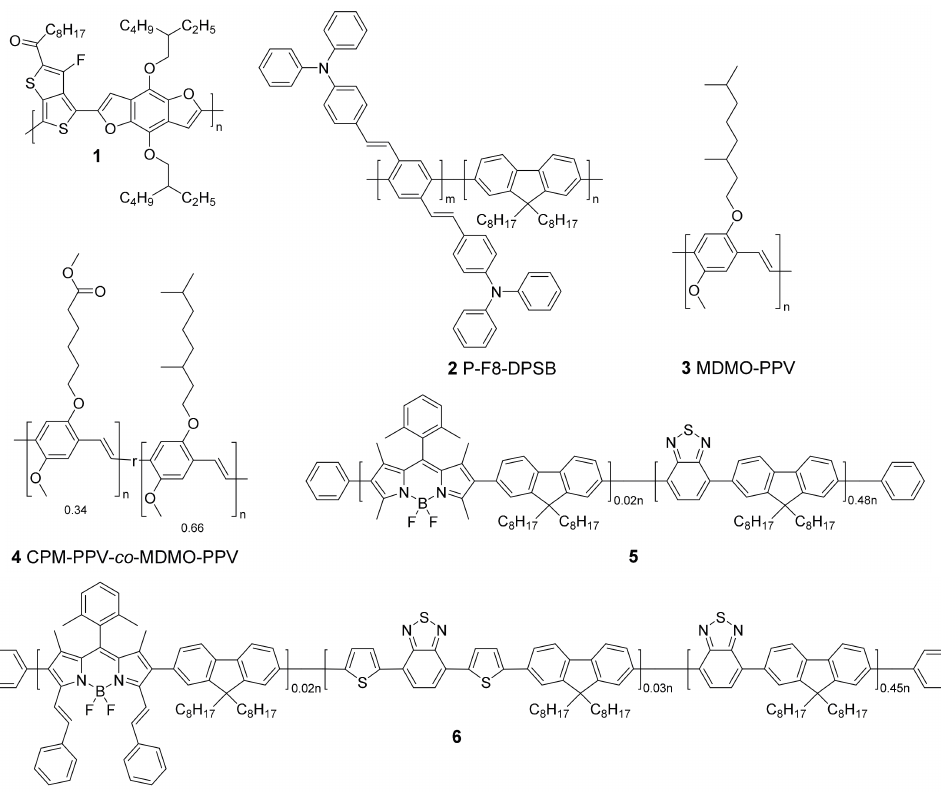
Figure 2. Structures of conjugated polymers with absorption in the near-infrared region because of the strong donor-strong acceptor approach ( 1 ), two-photon excitation ( 2 – 4 ) and extra narrow emission peaks ( 5 , 6